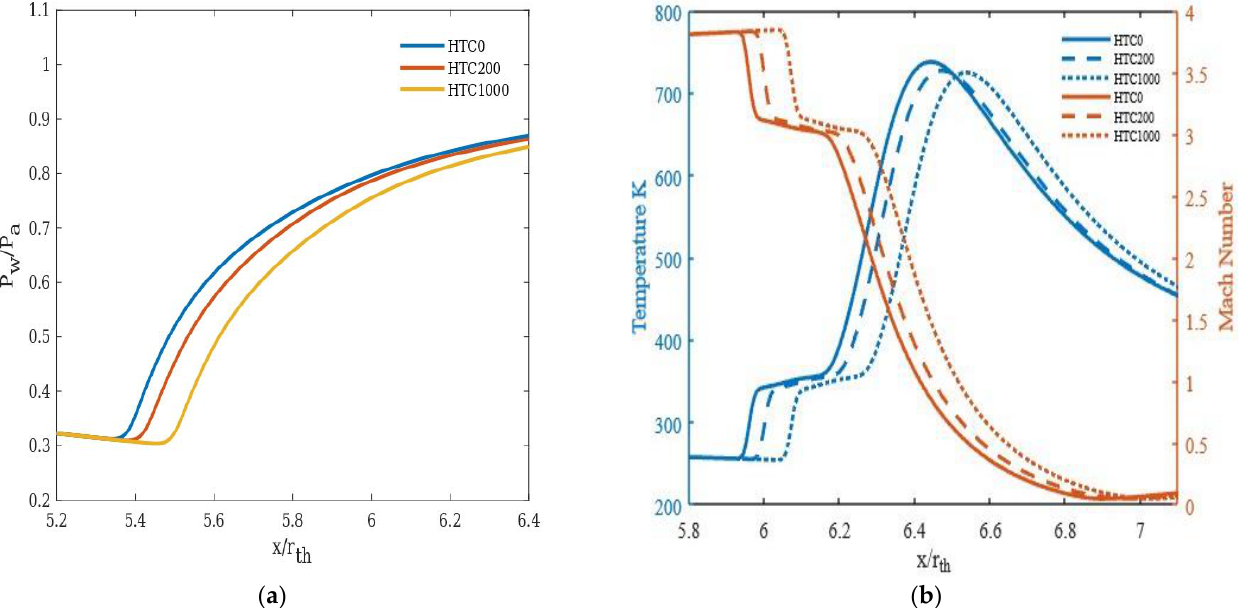
Figure 10. NPR 30 at an inlet temperature of 1000 K for different heat transfer coefficients: ( a ) Pres- sure distribution along the nozzle wall, ( b ) Temperature and Mach number variation at a distance y = 0.0015 m from the nozzle wall.